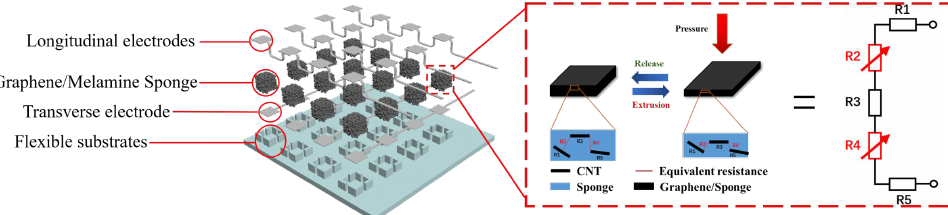
Figure 2. The sensing array of the 3D-printed